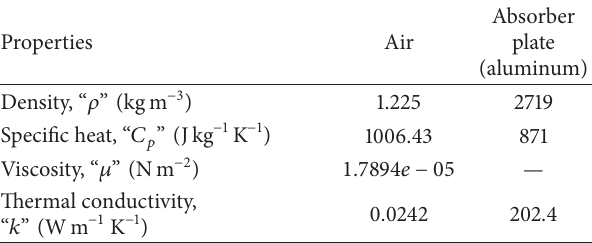
Table 3: Thermophysical properties of air and absorber plate for CFD